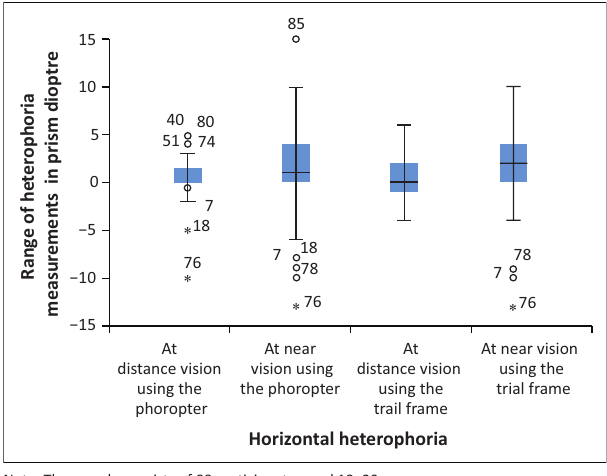
FIGURE 1: Box plots for the measurements of horizontal heterophorias using the phoropter and trial frame. 10203040